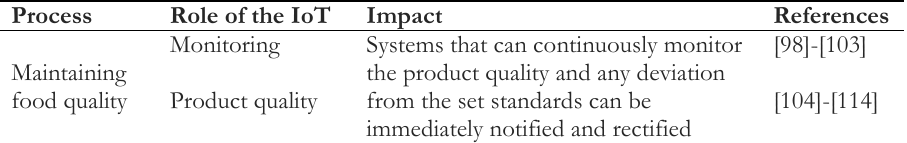
Table 8. Use of the IoT in maintaining food quality in the food supply chain.